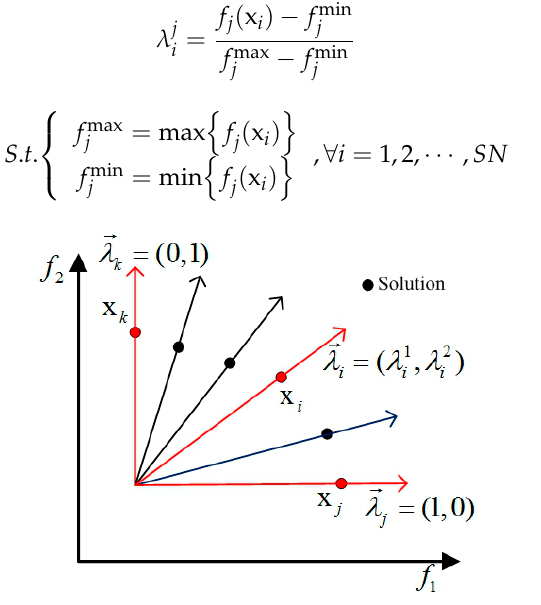
Figure 4. The spatial distribution of solutions’ weight vectors in objective space.